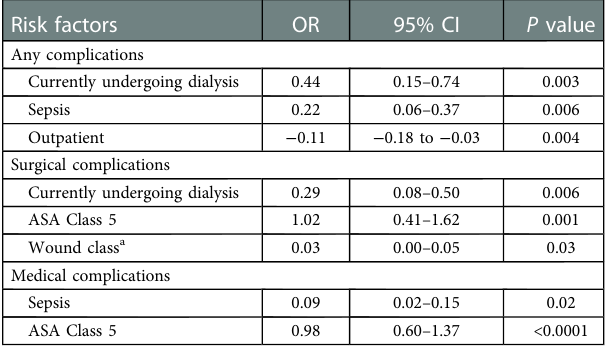
TABLE 5 Multivariate assessment of any, surgical or medical complication occurrence for all patients undergoing burn surgery.